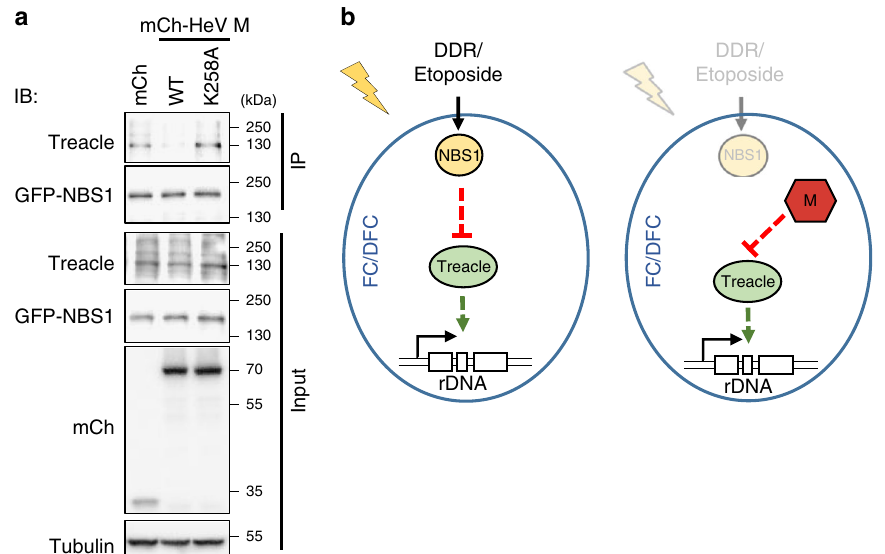
Fig. 9 HeV M protein disrupts the Treacle – NBS1 complex. a HEK-293T cells co-transfected to express the indicated mCherry (mCh) protein with NBS1-GFP were subjected to IP for NBS1-GFP followed by analysis by IB using the indicated antibodies; results are representative of 3 independent experiments. b Models for (left panel) DDR-mediated and (right panel) HeV M protein-mediated inhibition of rRNA synthesis. Treacle is required for basal rRNA synthesis and localizes to Treacle-enriched subnucleolar compartments which appear to correspond to FC/DFC. (Left panel) During the DDR, Treacle function is inhibited by NBS1, with which Treacle forms a complex. (Right panel) During HeV infection, HeV M localizes to FC/DFC and binds to Treacle resulting in inhibition of Treacle-dependent function independently of a DDR; the capacity of M protein to disrupt the complex ( a ) suggests that it binds at or close to the Treacle – NBS1 interaction site to mimic a DDR-activated NBS1 – Treacle